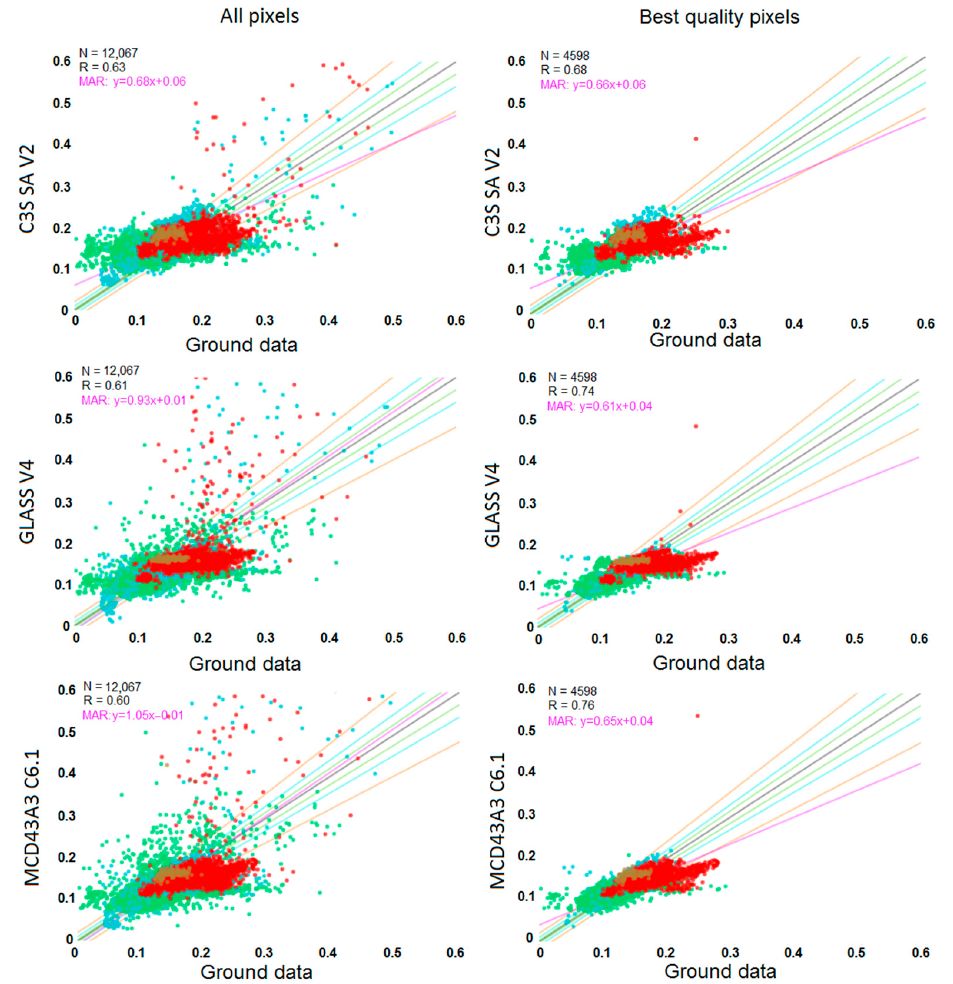
Figure 15. Direct validation of C3S V2 ( top ), GLASS V4 ( middle ), and MCD43A3 C6.1 ( bottom ) blue-sky albedo satellite products vs. REALS ground values during the 2000–2019 period for all pixels ( left ) and only best quality pixels ( right ). Green, blue, red, and orange points represent forest, crop, shrublands/herbaceous, and desert biome types, respectively. Table 12. Summary of the main statistics for the direct validation of C3S V2, GLASS V4, and REALS dataset in the 2000–2019 period. All pixels were taken into account.